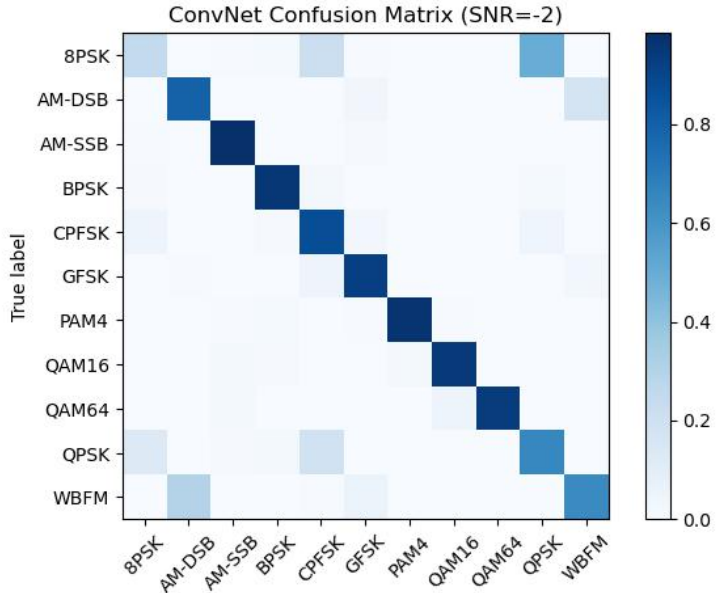
Figure 10. Confusion matrix on SNR = − 2 dB